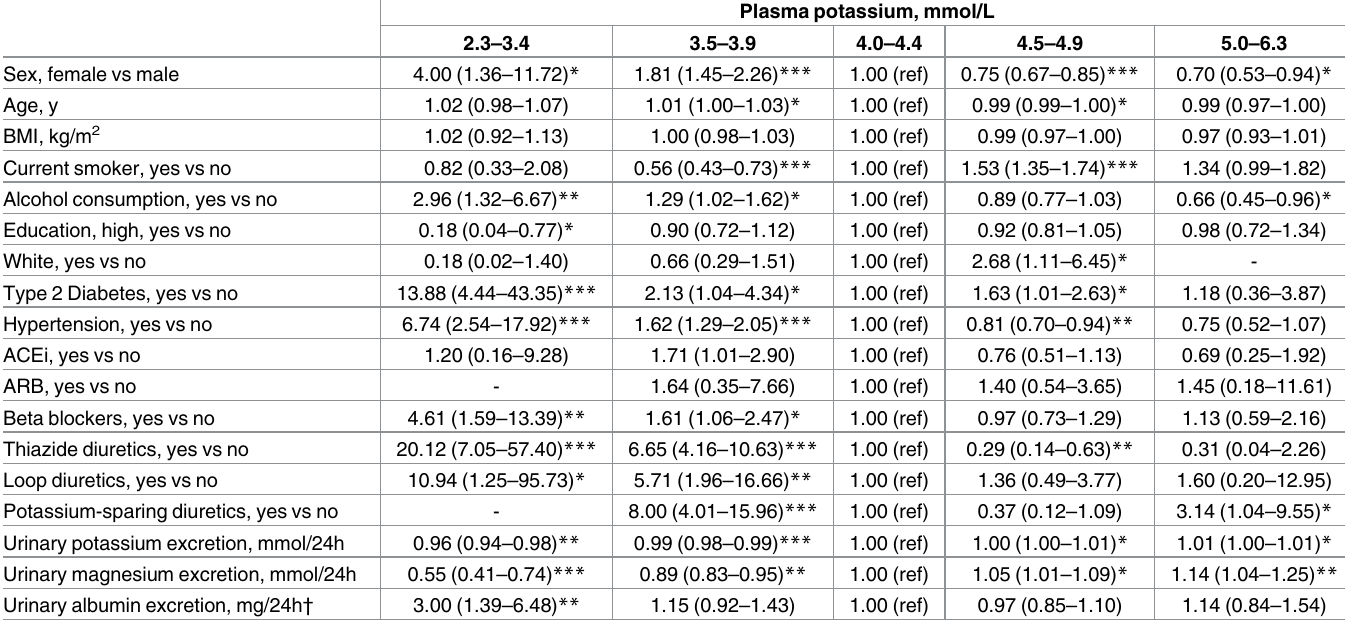
Table 2. Bivariable adjusted odds ratios (95% confidence intervals) combined with eGFR for risk factors of hypokalemia and hyperkalemiain 5,130 participants of the Prevention of Renal and Vascular End-Stage Disease(PREVEND)